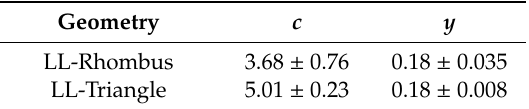
Table 1. Correlated Blasius equation parameters and 95% confidence intervals for LL-Rhombus and LL-Triangle geometries for 214 < Re l <